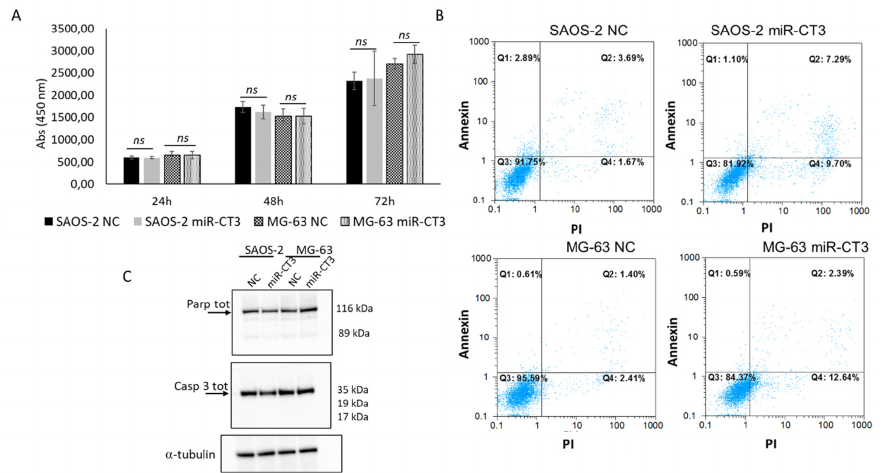
Figure 4. MiR-CT3 over-expression does not affect proliferation and apoptosis of OS cells ( A ) WST-1 proliferation assay of SAOS-2 and MG-63 cells transfected with miR-CT3 mimics and NC and analyzed after 24, 48 and 72 h post transfection (Mean ± SD, n = 3 triplicate; ns: not significant, p < 0.5). ( B ) Flow cytometric analysis of SAOS-2 and MG-63 cells, transfected with miR-CT3 mimics and NC, stained with Annexin V-FITC and PI. ( C ). Western blotting analysis of Parp total and Caspase3 total in SAOS-2 and MG-63 cells transfected with miR-CT3 mimics and NC. Tubulin was used as loading control.